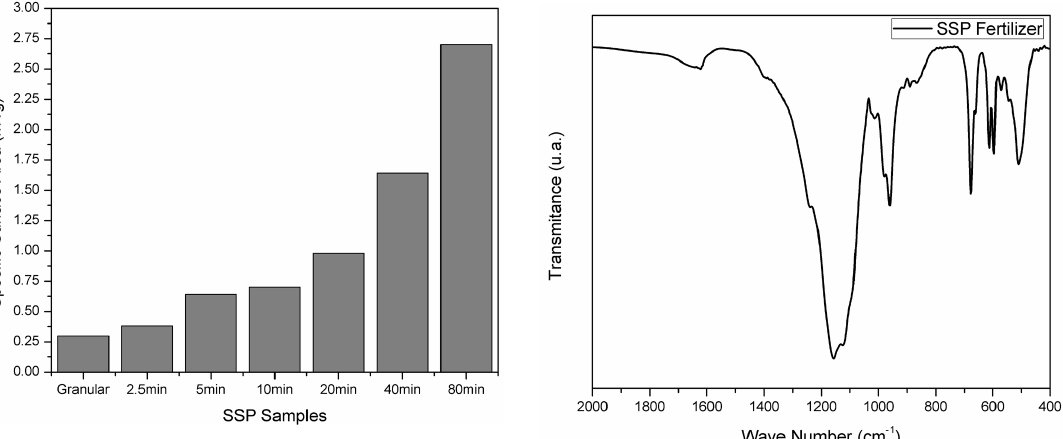
Figure 3. Specific surface are of simple superphosphate (SSP) fertilizer milled at different times. Figure 4. FTIR spectrum of original (not milled) SSP